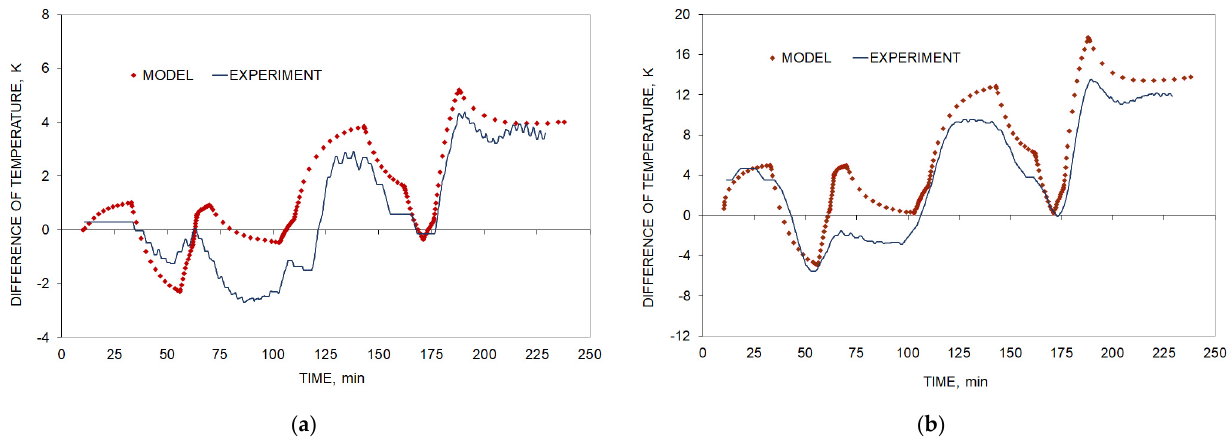
Figure 6. Comparison of the calculated and measured temperature differences for medium-deep and deep points at the ( a ) top middle and ( b ) bottom middle of the drum, during an OR HOT start cycle.